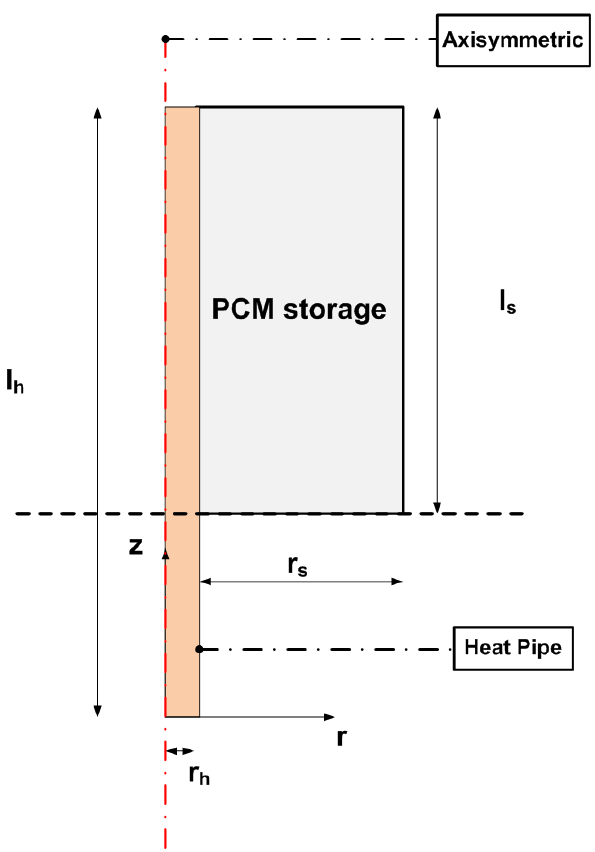
Figure 3. The physical configuration of a PCM storage system embedded with vertical heat pipe.